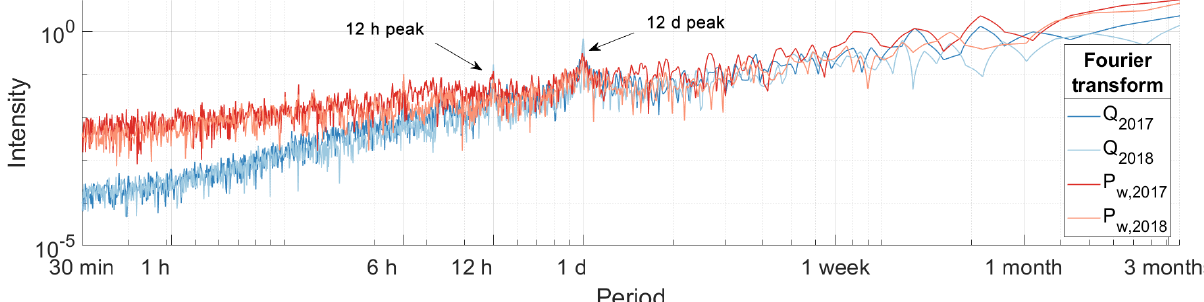
Figure A1. Power spectrum of the water discharge Q (blue lines) and subglacial channel-flow-induced seismic power P w (red lines) shown as a function of the period. Both axes are in logarithmic scale (1 over the